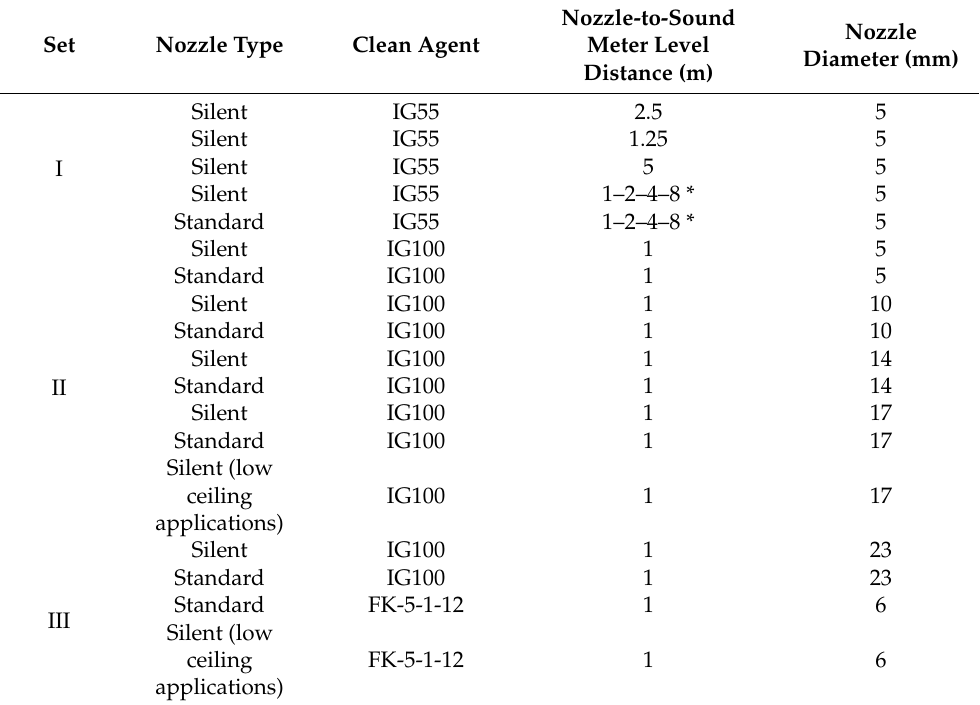
Table 3. Detailed list of the investigated configurations (*, multiple data series recorded for each tested distance at various angular